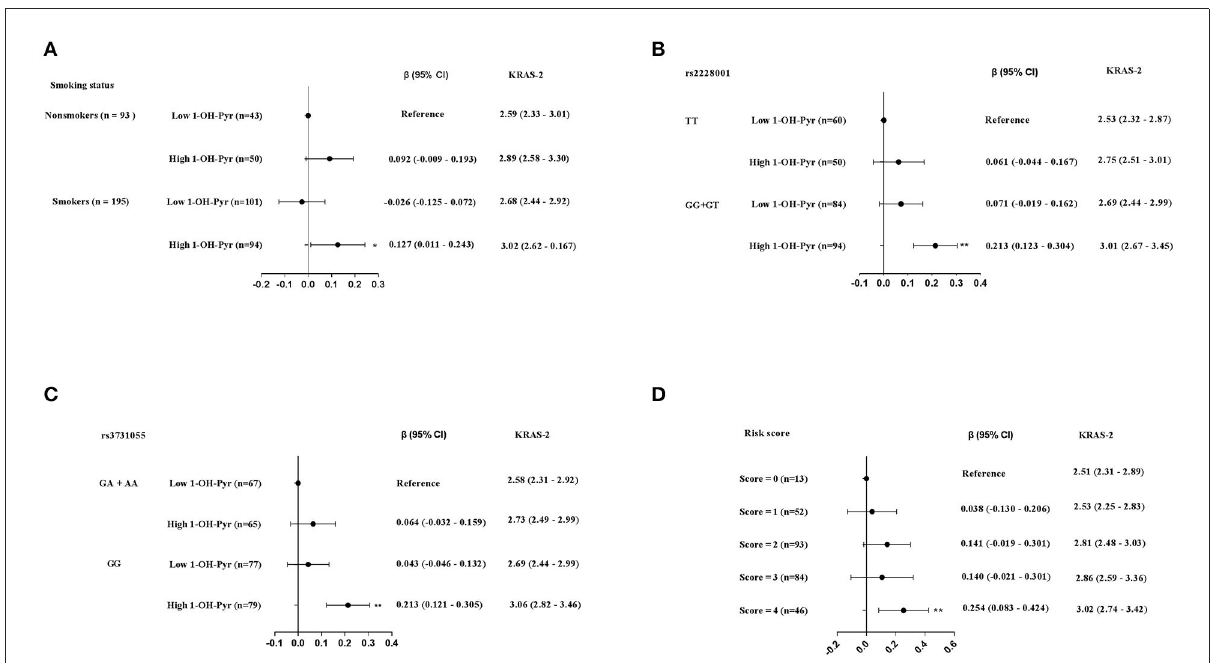
FIGURE4 The joint effects of high level of urinary 1-OH-Pyr with (A) smoking status. (B) rs2228001 GG + GT genotype on KRAS-2. (C) rs3731055 GG genotype on KRAS-2. (D) The joint effects of the above four risk factors on KRAS-2. The black solid dot and black line in panels represent β (95% CI), while the KRAS-2 levels are represented as median (25th, 75th percentiles); ** p <